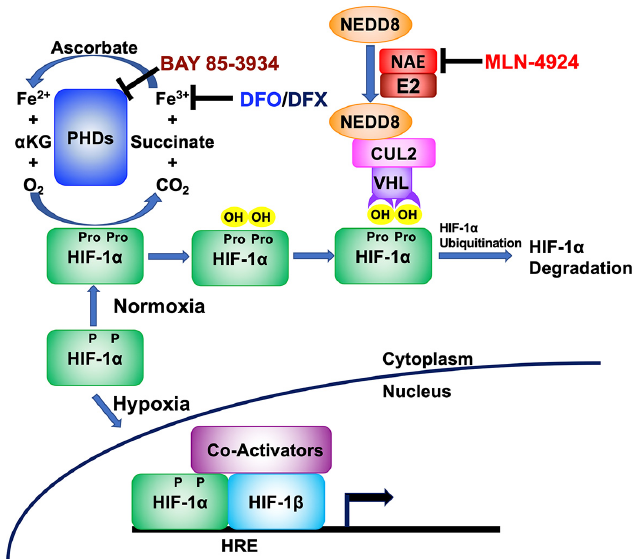
Figure 1. Schematic showing where some drugs stabilize HIF-1 α by targeting different parts of the hypoxia signaling pathway. Under normoxic growth conditions, HIF-1 α protein is synthesized. However, it is then hydroxylated on proline residues (Pro) by prolyl-hydroxylases (PHDs), cellular enzymes that use α -ketoglutarate ( α KG), ferrous iron (Fe 2+ ), and oxygen as co-factors. The hydroxylated form of HIF-1 α is then recognized by the VHL/Cullen 2 (CUL2) complex for ubiquitination, if Cullen 2 has been NEDDylated by the NEDD8-activating enzyme (NAE). Finally, ubiquitinated HIF-1 α is then rapidly degraded via the cellular proteasome complex. However, if this pathway is disrupted, HIF-1 α protein accumulates, is translocated to the nucleus, dimerizes with constitutively stable HIF-1 β , and binds hypoxia-response elements (HREs) located within cellular and EBV genomes. DFO and DFX chelate ferric iron (Fe 3+ ), preventing its conversion to Fe 2+ ; BAY 85-3934 directly binds PHDs, inhibiting their activity; and MLN-4924 directly binds NAE, inhibiting NEDDylation of Cullen